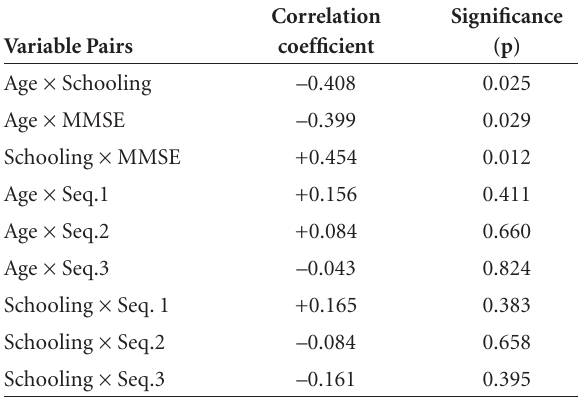
Table 1. Spearman’s correlations between sociodemographic and cognitive